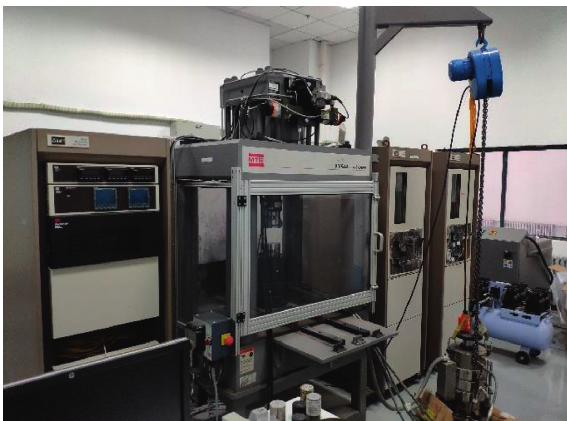
Figure 2: Rock mechanics test system.